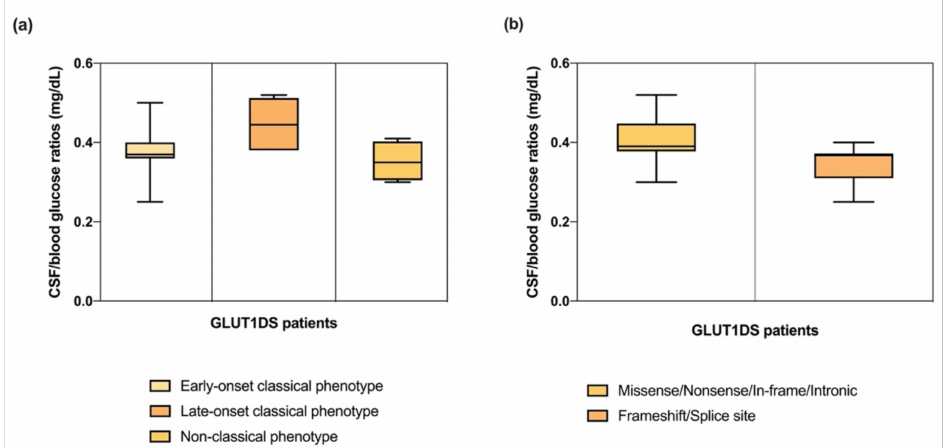
Figure 6. Genotype, phenotype, and biochemical correlations. ( a ) Boxplot shows CSF/blood glucose ratios with three different phenotypes. ( b ) Boxplot displays CSF/blood glucose ratios with different type of